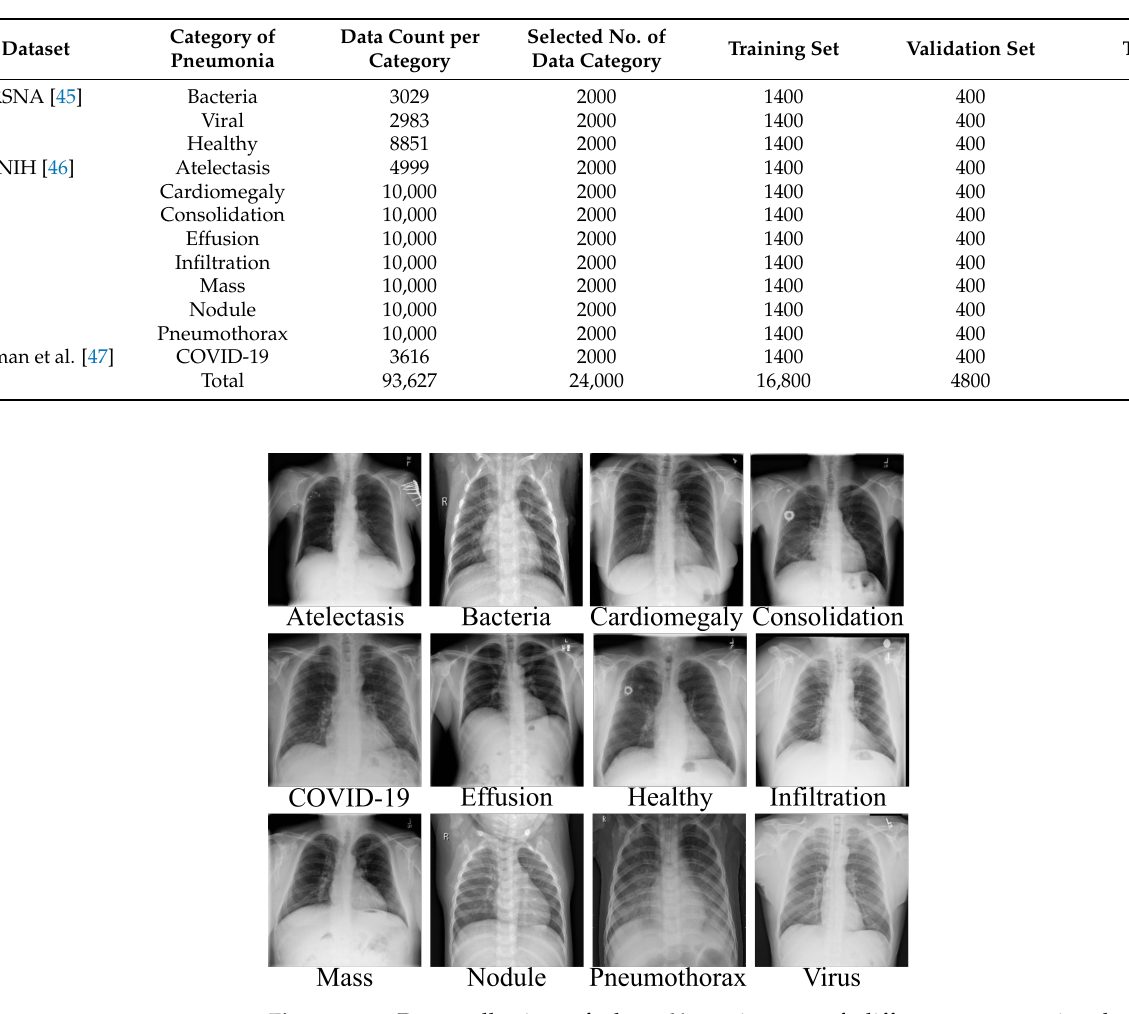
Figure 1. Data collection of chest X-ray images of different pneumonia-related illnesses including COVID-19.